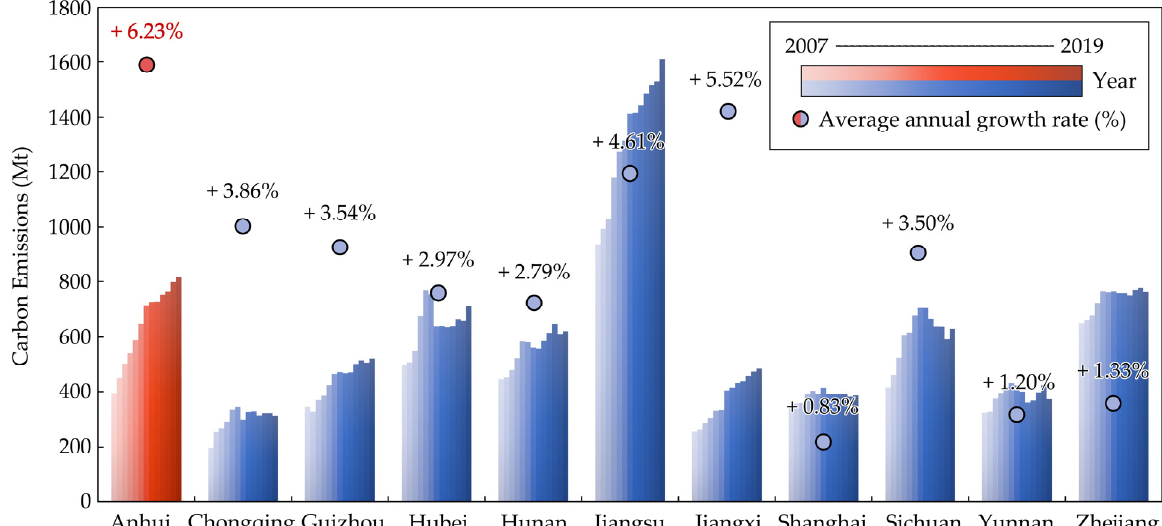
Figure 2. Long time series evolution trend of CEs among the YREB (2007–2019).